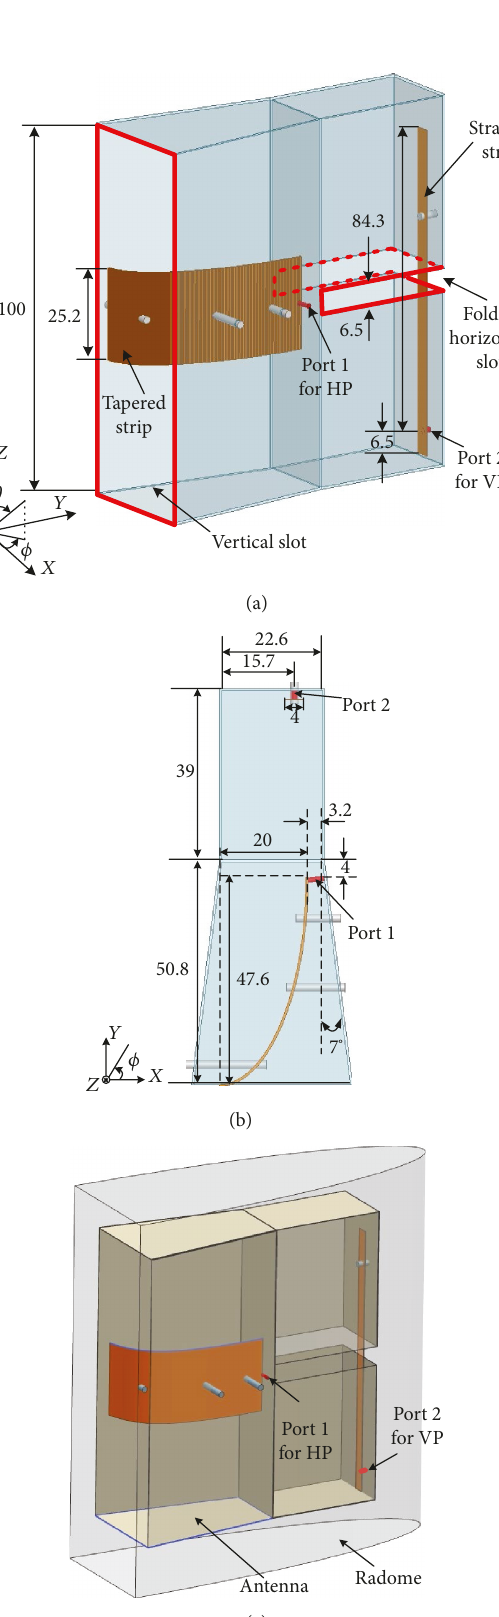
Figure 10: The structure of a wideband DP quasi-omnidirectional antenna (unit in mm): (a) perspective view, (b) top view, and (c) package with a radome of blade